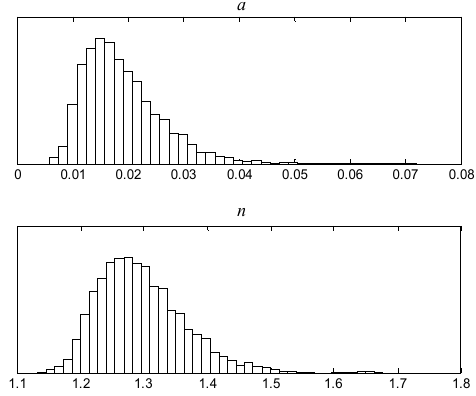
Figure 6. Histograms for random variable distribution after updating.